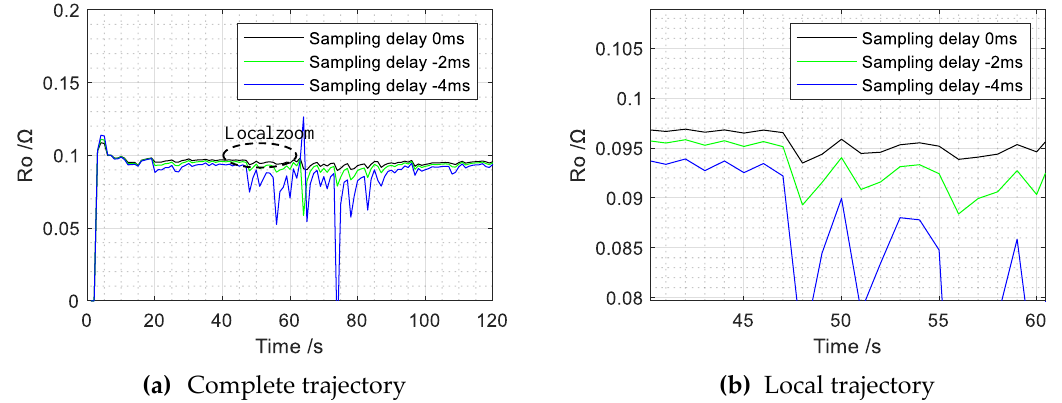
Figure 8. The trajectories of estimated internal resistance with negative sampling delays.